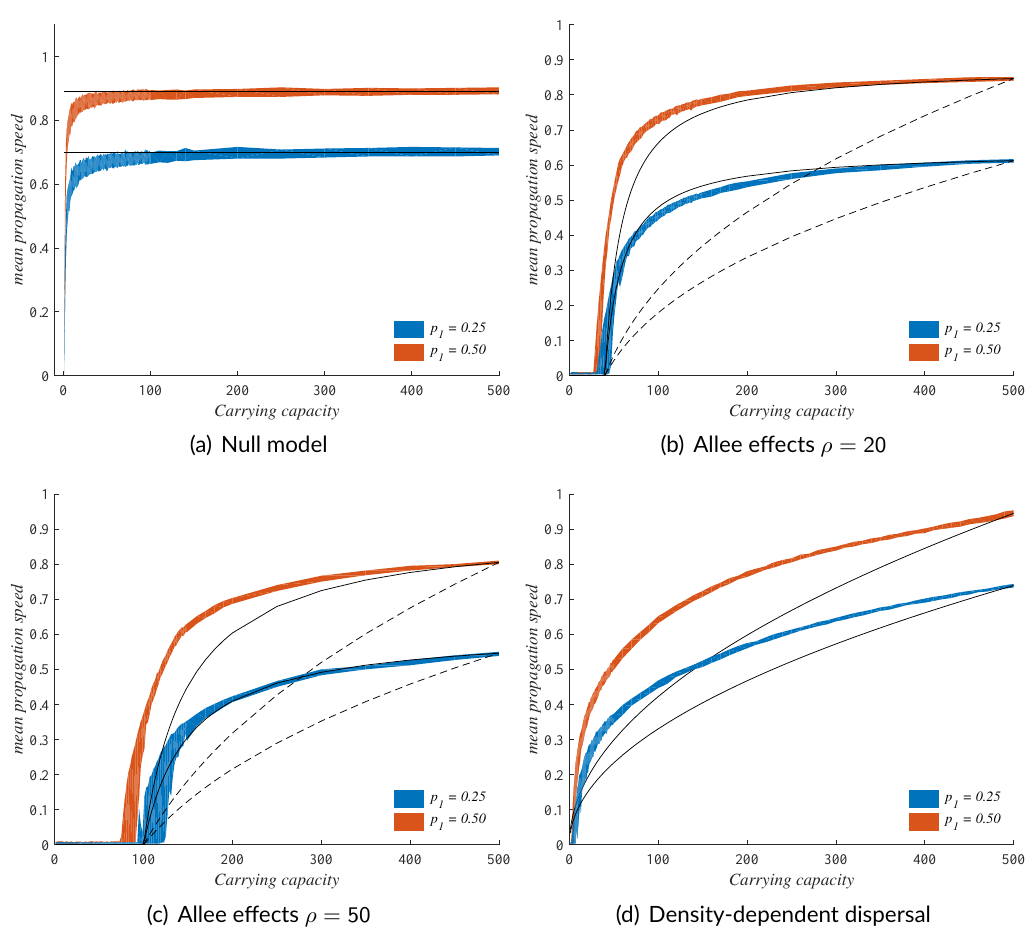
Figure 4 – Propagation speed vs carrying capacity: IBM simulations and predictions of the reaction-diffusion theory. The shaded regions correspond to 99% confidence intervals for the mean speed obtained with individual-based simulations after 300 generations, with 200 replicate simulations for each scenario. The plain lines correspond to the propagation speed given by the analytical theory: formulas (2) for panel (a), formula (8) for panels (b) and (c) and formula (9) for panel (d). In panels (b),(c), the dashed lines correspond to the theoretical propagation speed obtained with classical growth function (3). In all cases, we set R = e 1 in the IBM simulations and r = 1 in the reaction-diffusion framework. The diffusion coefficients D in the reaction-diffusion framework were fixed such that, in each scenario, the theoretical speed equals the average IBM speed for K = 500 . The parameter values p 1 in panel (d) (positive density-dependent dispersal) correspond to a = 500 individuals in formula population O i